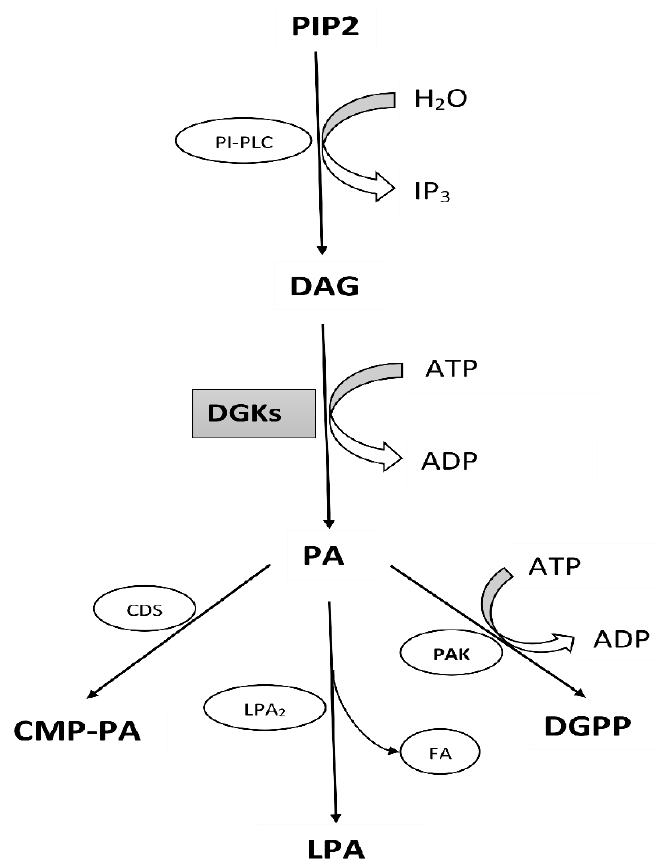
An overview of the general function of DGKs in the eukaryotic cells. After the phosphatidylinositol-phospholipase C (PI-PLC) actions that produce DAG (diacylglycerol), the DGK (diacylglycerol kinase) catalyzes the formation of PA (phosphatidic acid), which is the precursor of cytidine monophosphate-phosphatidic acid (CMP-PA) by CMP-PA synthase (CDS), diacylglycerol pyrophosphate (DGPP), and Lysophosphatidic acid (1-acyl-2-lyso-sn-glycero-3-phosphatidic acid; LPA) formation via the phospholipases A2 (PLA2) in eukaryote cells during the salt stress treatment.